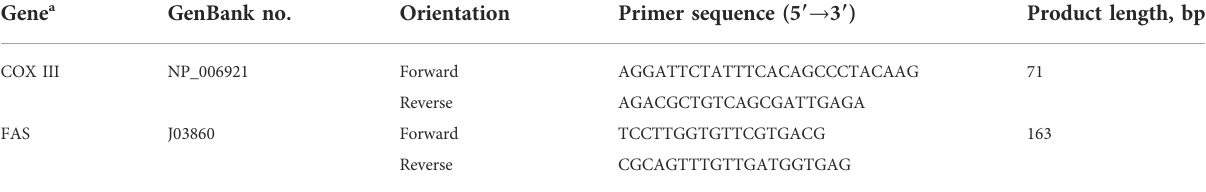
TABLE 1 PCR primers of relevant genes used in this